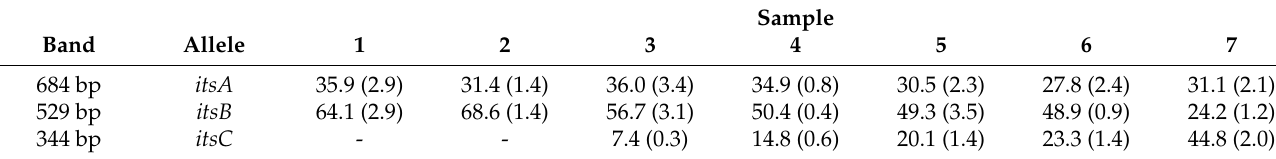
Table 2. Replicate PCR-RFLP analyses (by using Msp I) on selected samples. The values are expressed as % of electrophoretic band intensity calculated on the sum of the three bands involved, the average of four replicates. Values in brackets are standard deviations of the